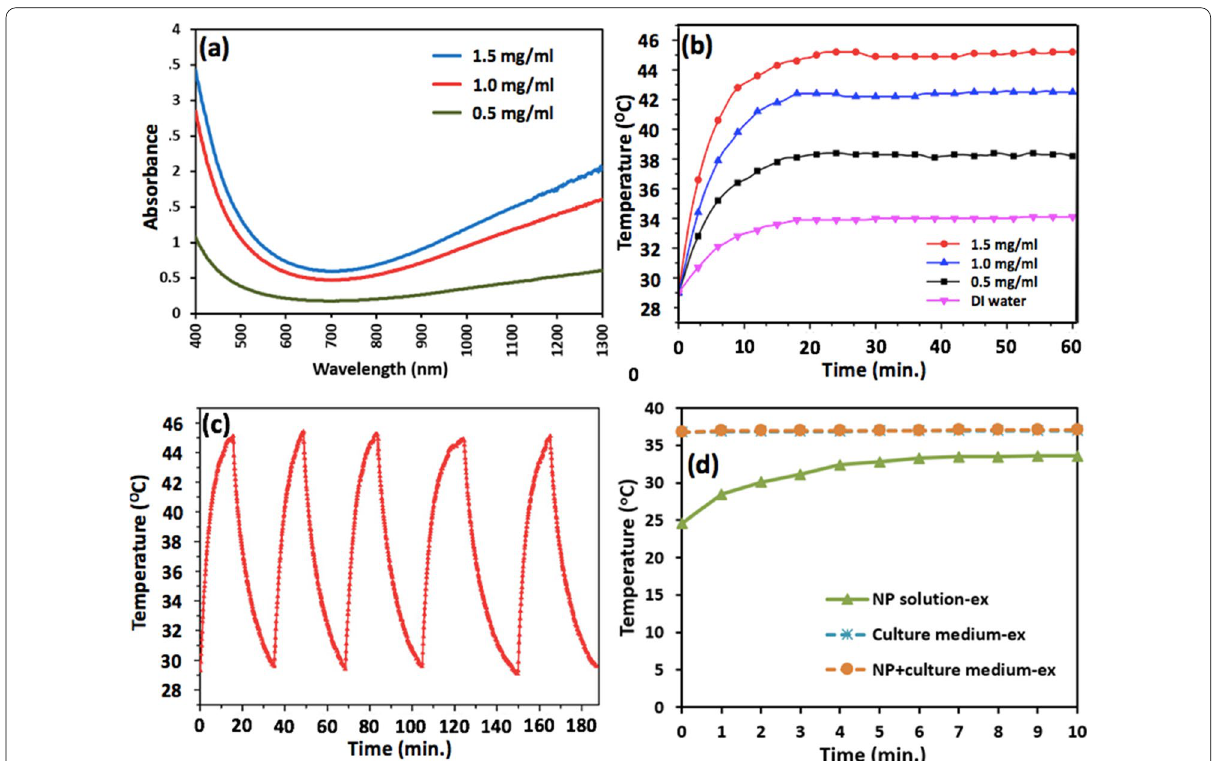
Fig. 3 Optical and photothermal properties. a Optical absorbance spectra and the profiles of time‑course temperature of NIR‑irradiated NP solution in b , c a cuvette and in d a petri dish are depicted. Ex symbolizes the profiles of beam‑expanded cases; NP concentration of 1.5 mg/ml and optical power density of 50 mW/cm 2 were used in ( d ); the duration of NIR‑irradiation per cycle in c is 15 min